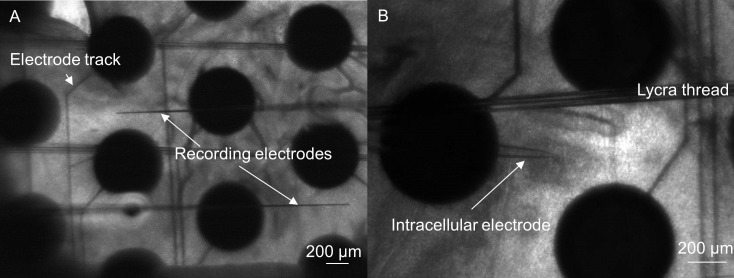
In vitro stimulation and recording.The retina was placed on a multi-electrode array (large black circles) and held in place with a perfusion chamber and lycra threads. A) Two extracellular electrodes were used to obtain recordings from the retinal surface. B) A hole was made in the inner limiting membrane to expose the RGCs. Once exposed, an intracellular glass electrode was used to obtain whole cell recordings of RGCs.